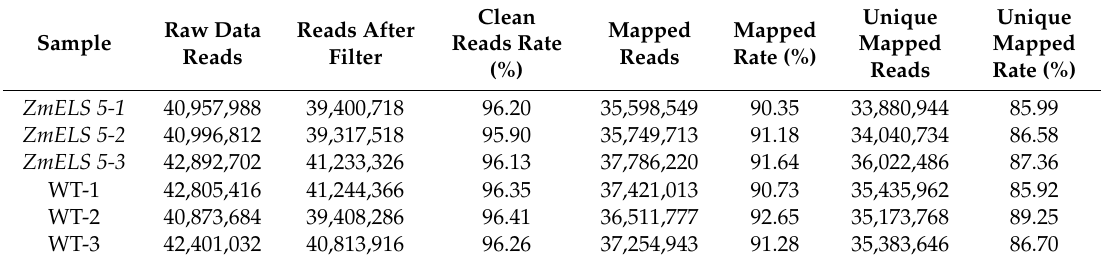
Table 1. Overview of mapping quality in RNA-seq data.